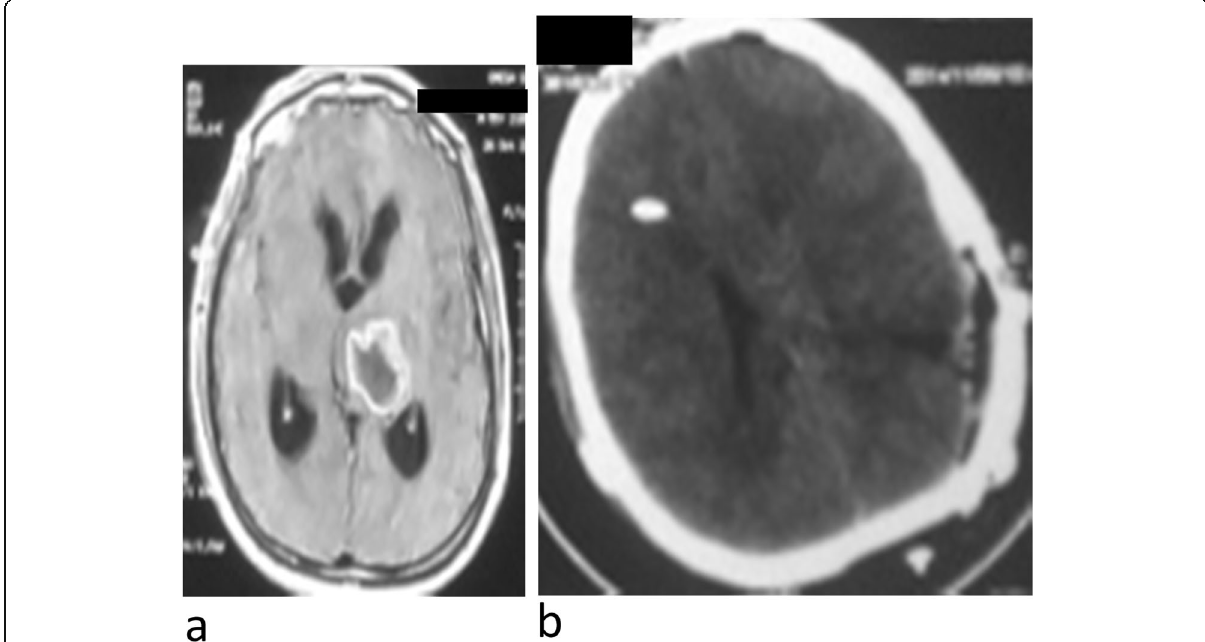
Fig. 9 a On the left MRI axial T1 contrast for left thalamic glioma and b on the right follow up CT showing removal through parietal transcortical approach